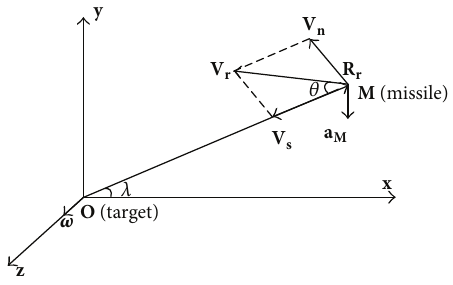
Figure 1: The relative movement of target and